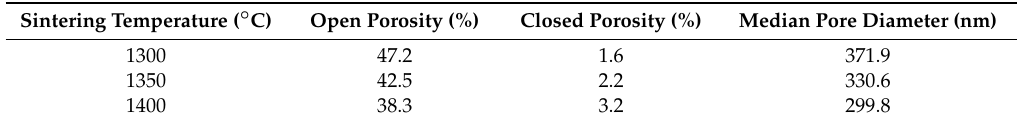
Table 1. Porosities and median pore diameters of porous Al 2 O 3 ceramics (30 vol.% Al 2 O 3 in the slurries).